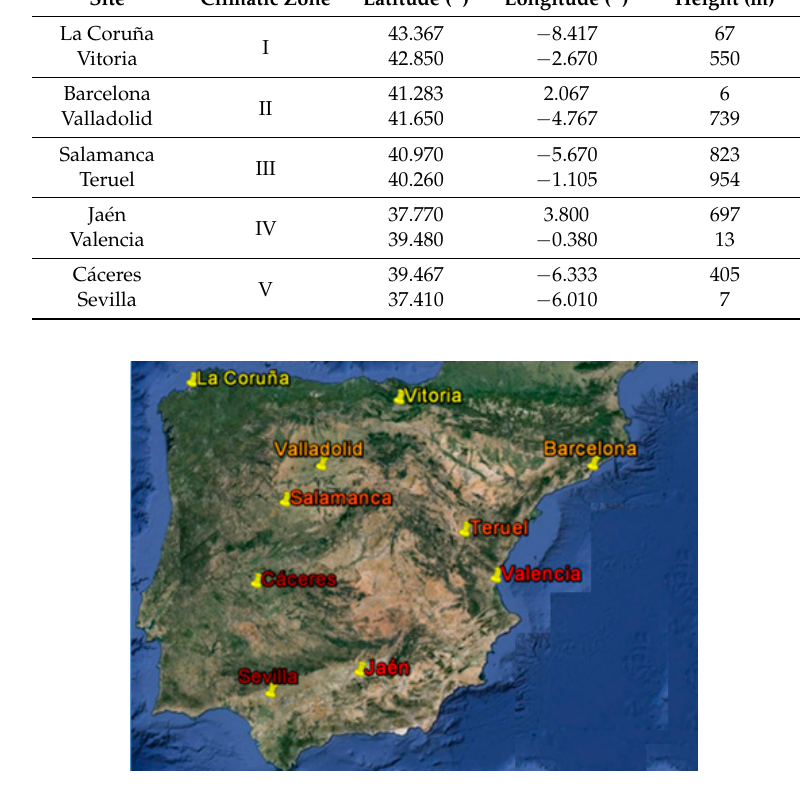
Table 14. Selected sites geographical data.